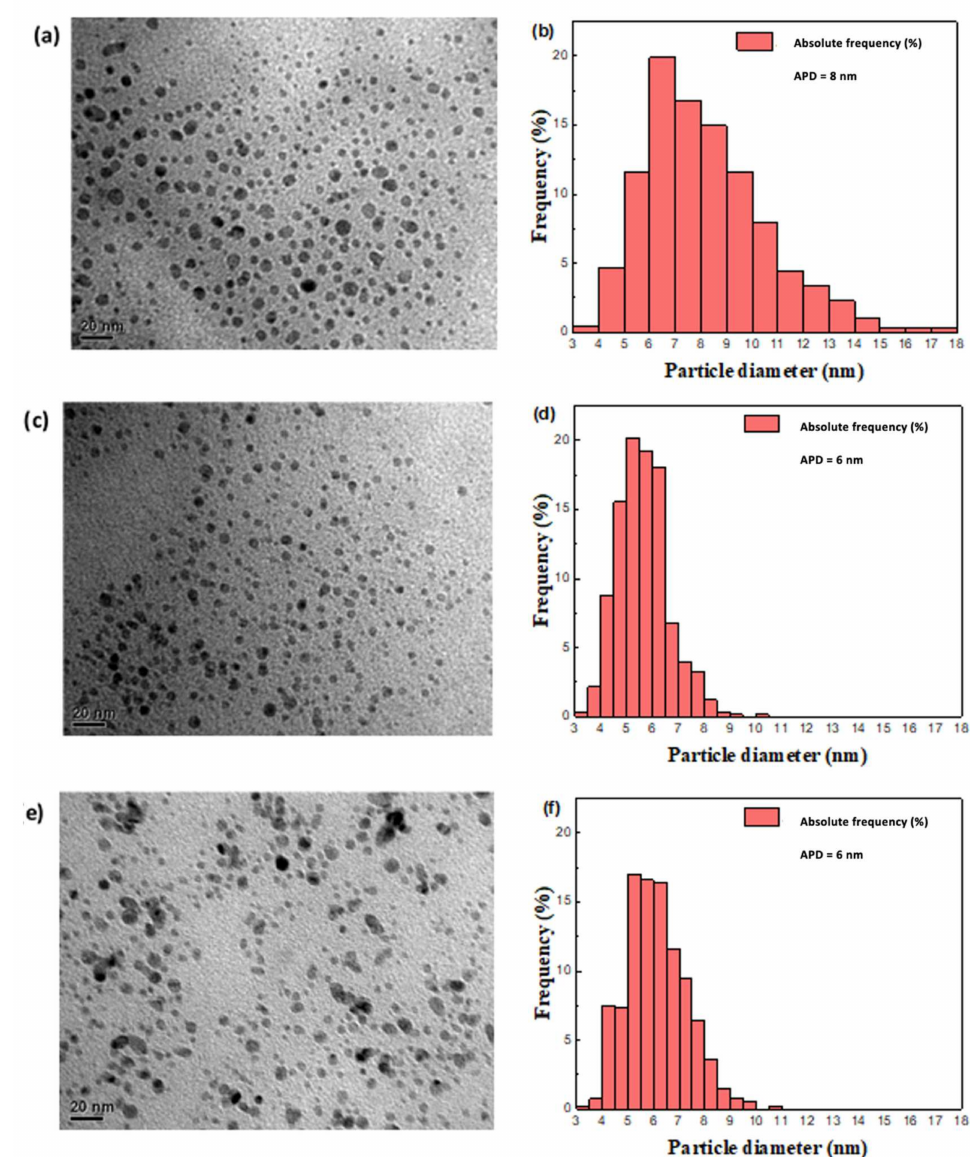
Figure 1. TEM images of the copper nanoparticles (NPs) obtained via the chemical reduction method ( a ) pH = 4, ( c ) pH = 7 and ( e ) pH = 9. Histograms of the Cu NPs ( b ) pH = 4, ( d ) pH = 7 and ( f ) pH = 9. ADP = Average Particle